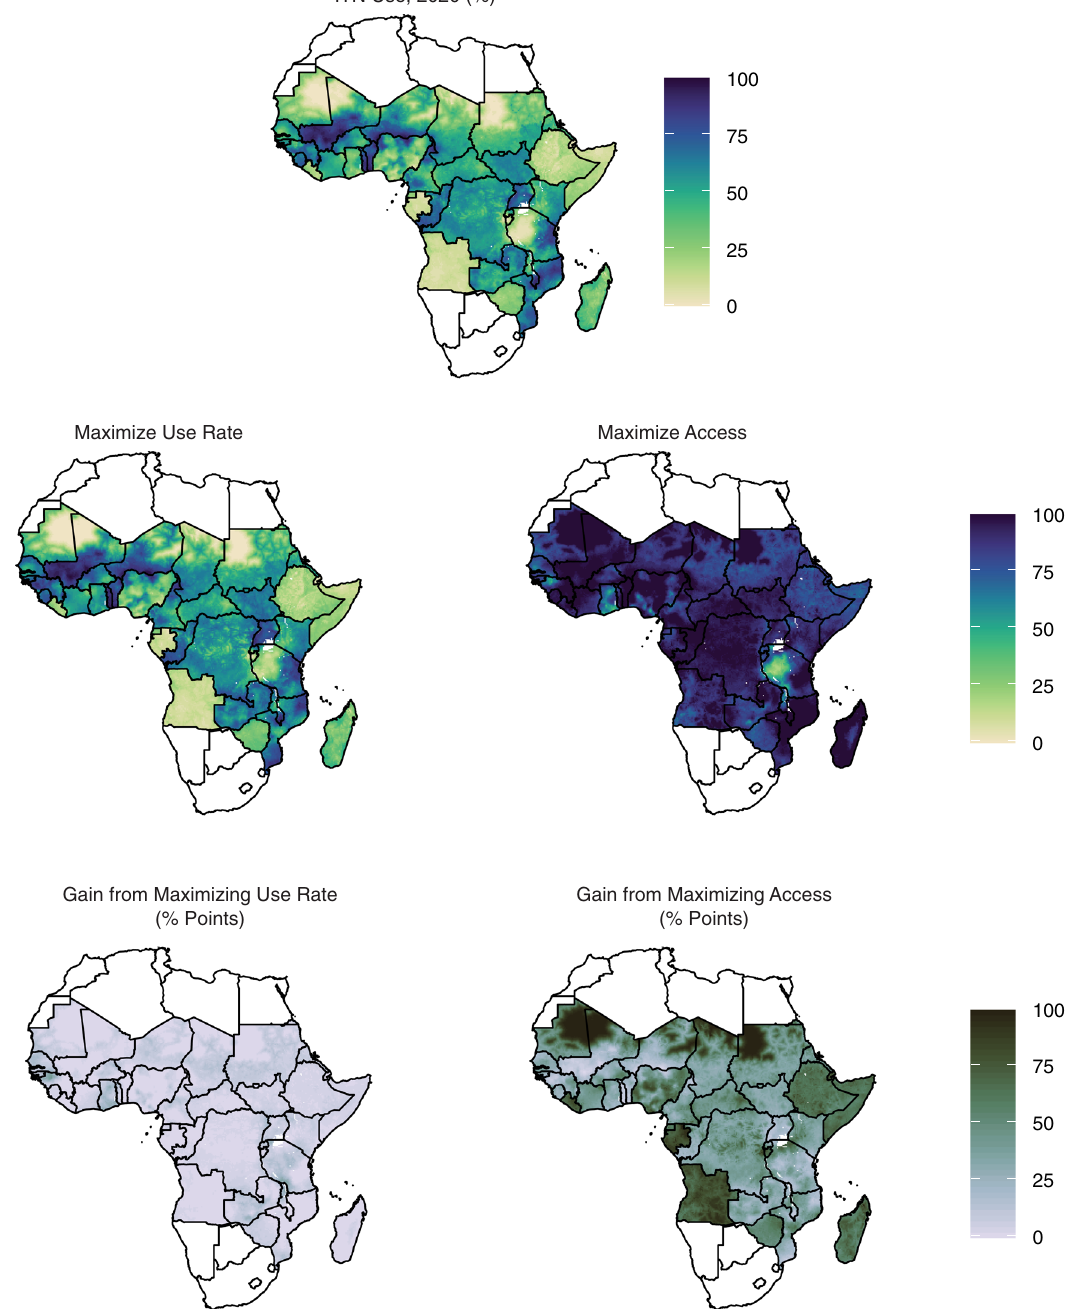
Fig. 6 Magnitude of change in insecticide-treated net (ITN) use possible from increasing use rate versus increasing access. The top row shows estimated ITN use in 2020. The second row shows what use could be if access remained unchanged and the use rate were set to 100% (left), compared to if the use rate remained unchanged and access was set to 100% (right). The fi nal row shows the magnitude gain in use from each of these two scenarios. With few exceptions, increasing access has a larger impact than increasing the use